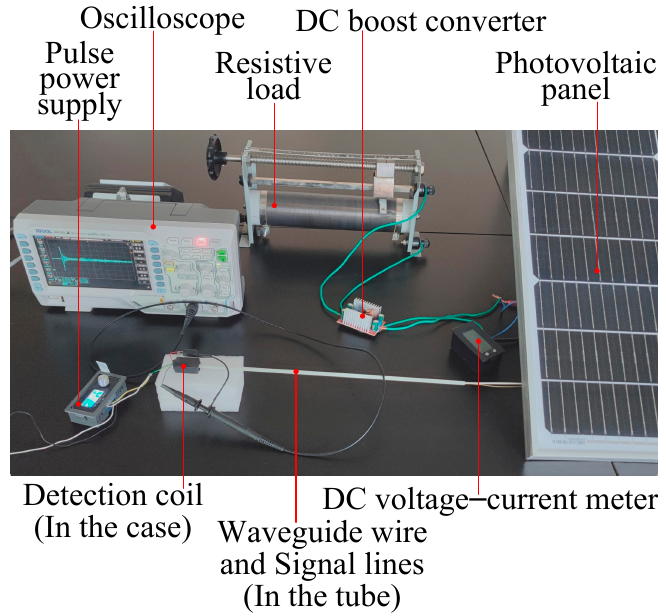
Figure 11. The experimental platform.